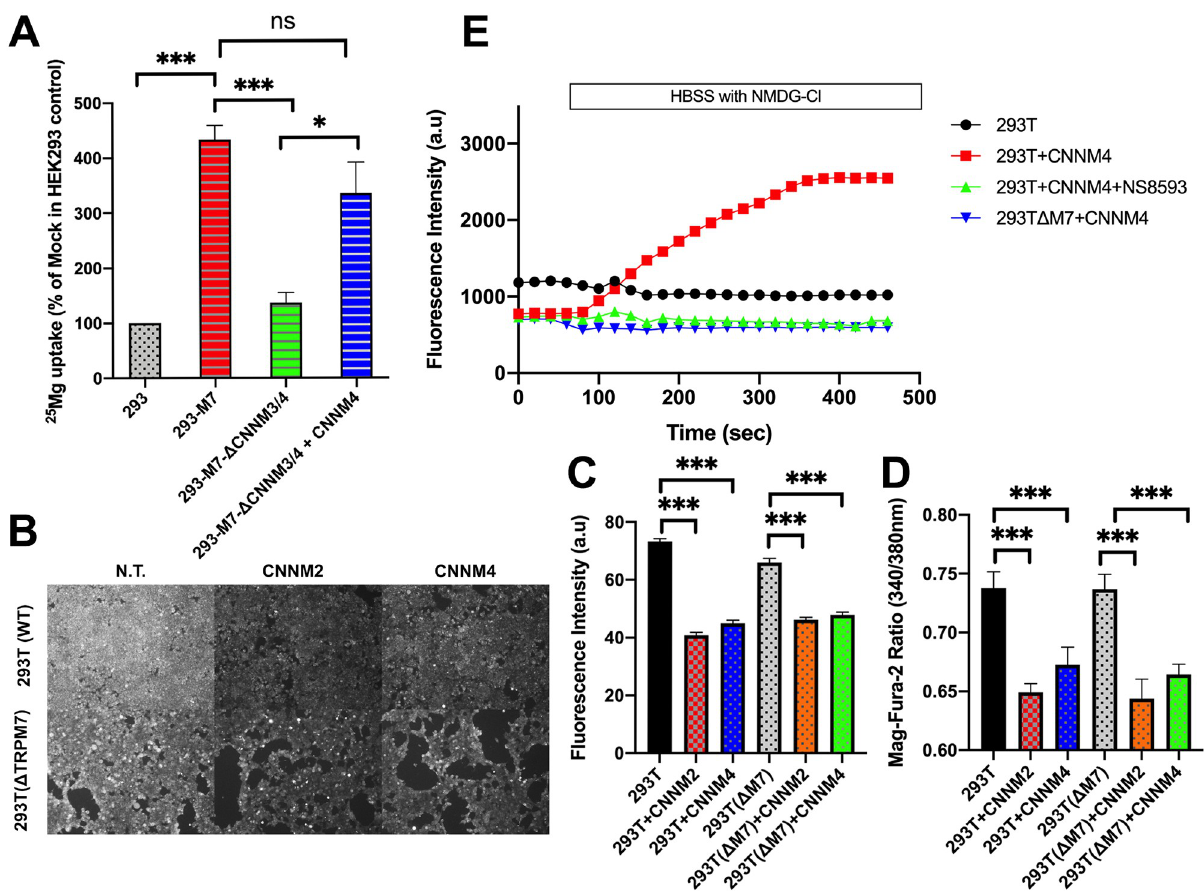
Fig 3. CNNMs have TRPM7-dependent and independent activities. (A) A 25 Mg uptake assay was employed to assay TRPM7 channel function and its dependence on CNNMs. Moreover, 293-TRPM7 cells have significantly higher 25 Mg uptake than the negative control T-REx-293 cell line (293), which expresses the Tet Repressor protein. Compared to 293-TRPM7 cells, 293-M7- Δ CNNM3/4 exhibited significantly lower 25 Mg uptake, which was increased by reexpression of CNNM4. � = p < 0.05 and ��� = p < 0.001, 1-way ANOVA plus Tukey post hoc. (B) Similar levels of free Mg 2+ were detected in HEK-293T (293T(WT)) and HEK-293T TRPM7 KO (293T( Δ M7)) cells using the Mag-Fluo4 Mg 2+ indicator. White scale bar = 100 μ M. Overexpression of CNNM2 or CNNM4 substantially reduced cytosolic Mg 2+ in both cell lines to similar degrees. (C) Quantitation of the results from (B). n = 50. ��� indicates a p -value of less than 0.001. (D) Mag-Fura-2 was also employed to compare the Mg 2+ levels between 293T(WT), 293T( Δ M7), and 293T( Δ M7) transfected with CNNM2 or CNNM4. Images of the cells were taken using a 510-nm filter from excitation at 340 nm versus 380 nm on an inverted Olympus IX70 fluorescence microscope, and the ratio of fluorescence intensity of the cells from excitation at the 340 nm versus 380 nm wavelengths (30 cells) was quantified. ��� indicates a p -value of less than 0.001. (E) 293T(WT), 293T(WT) transfected with CNNM4, 293T(WT) transfected with CNNM4 and treated with the TRPM7 channel inhibitor NS85903 (10 μ M), and 293T( Δ M7) cells transfected with CNNM4 were loaded with Mag-Fluo4. The fluorescence intensity of the cells (mean of 50 cells) were measured for 1 minute before the extracellular solution bathing the cells was replaced with a Na + free solution (replacing NaCl with NMDG-Cl) to inhibit Na + -dependent Mg 2+ extrusion by CNNM4. Replacement of the buffer occurred between 50 and 100 seconds after imaging began as indicated. Overexpression of CNNM4 increased the Mg 2+ levels in 293T(WT) but not 293T( Δ M7) cells, and the increase in Mg 2+ in 293T(WT) cells caused by CNNM4 overexpression could be blocked by NS8593, which was continually present in the imaging medium and was initially added just prior to imaging. The underlying data for this figure can be found in S1 Data. WT,